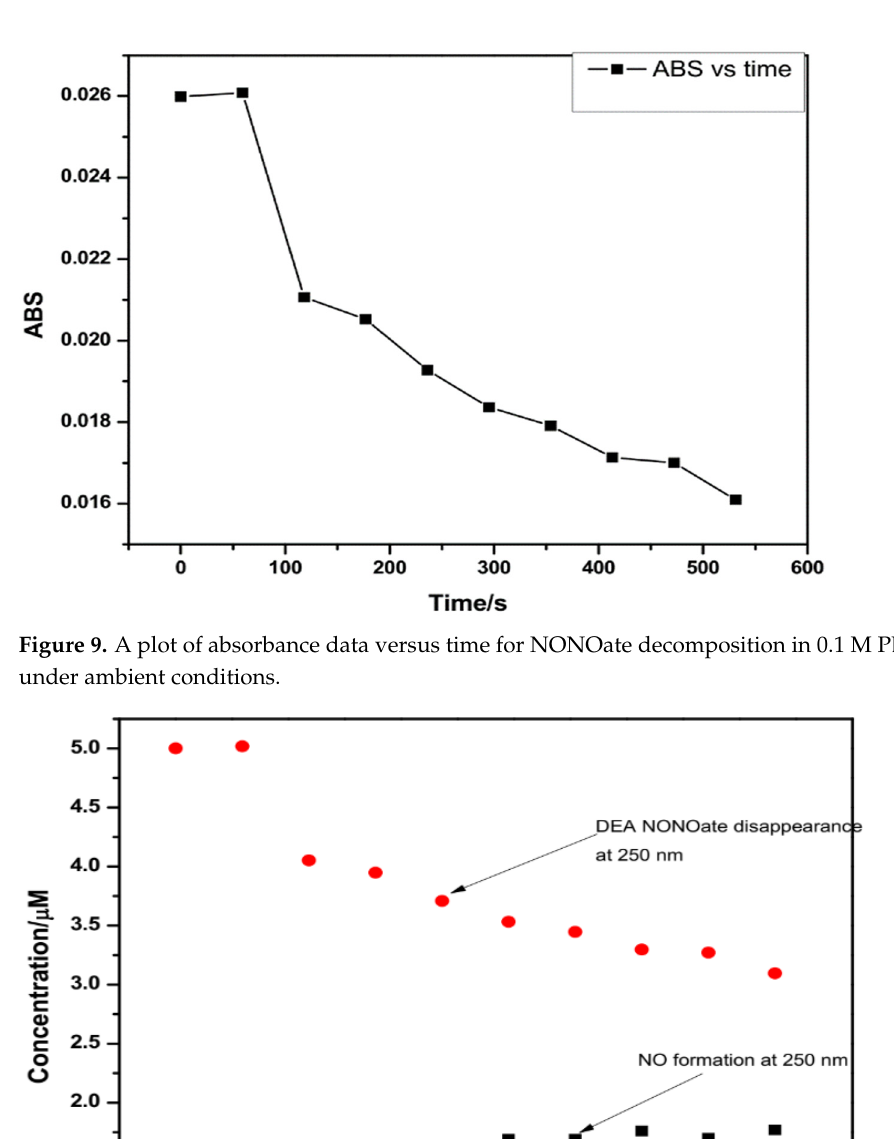
Table 2. Data relating NONOate concentration to that of NO obtained from time-dependent NON- Oate absorbance.